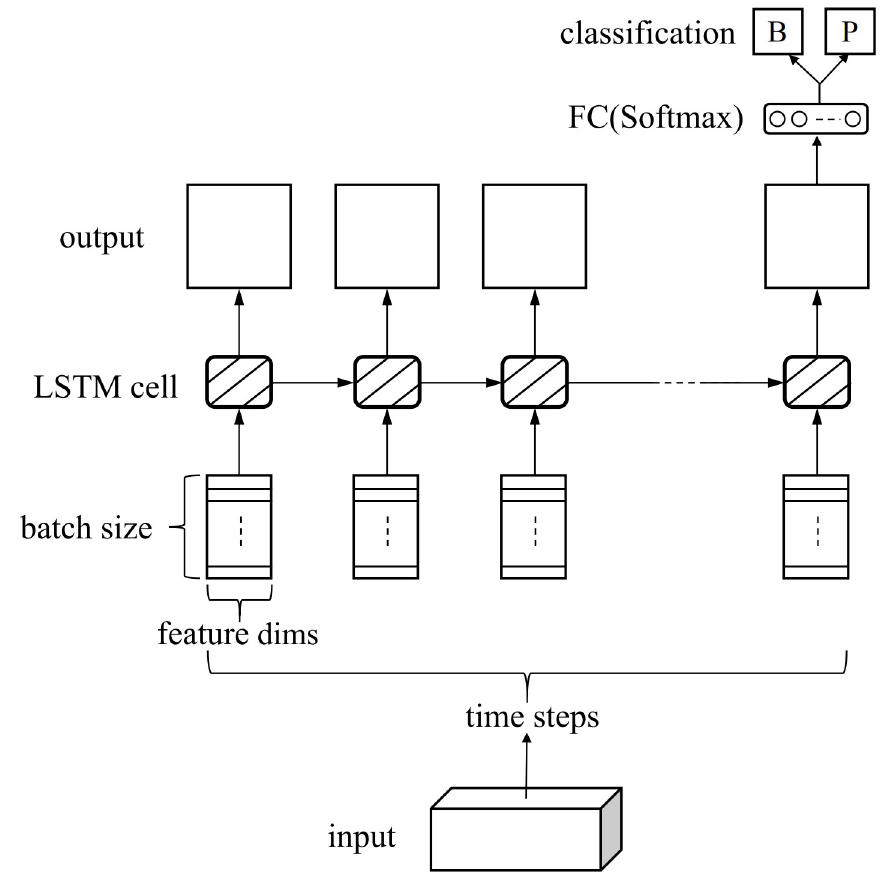
Fig 7. Structure of the LSTM